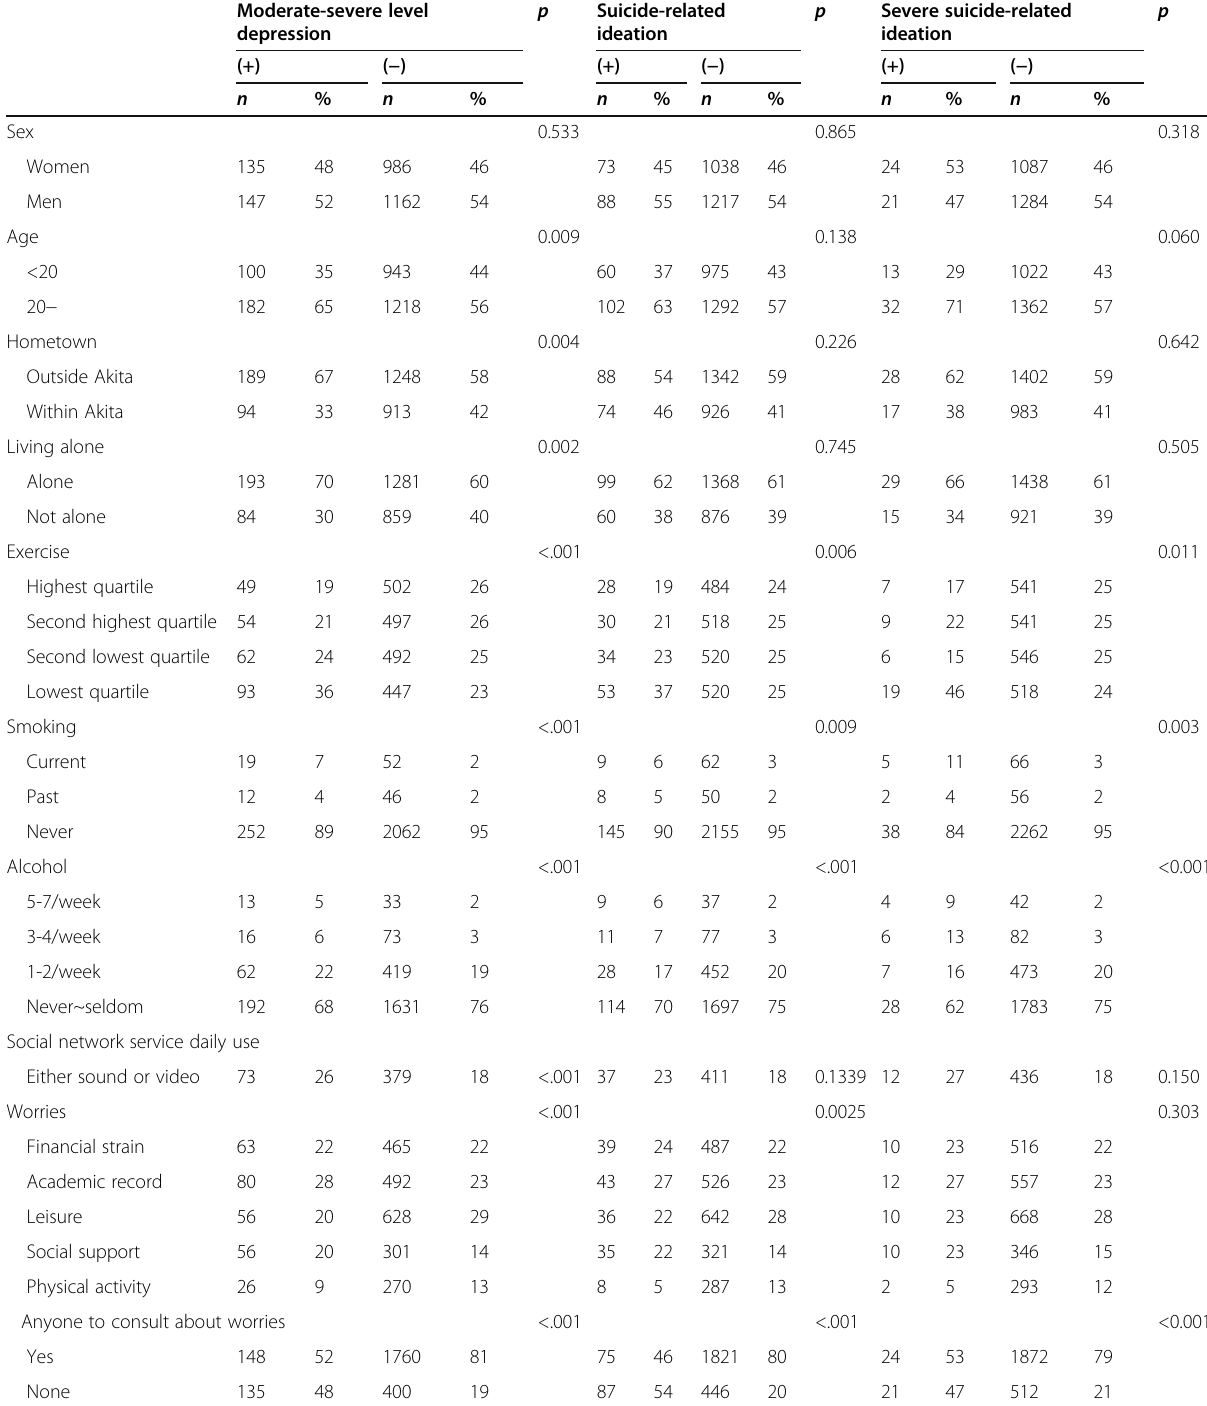
Table 3 Risk and protective factors for depressive symptoms Moderate-severe level